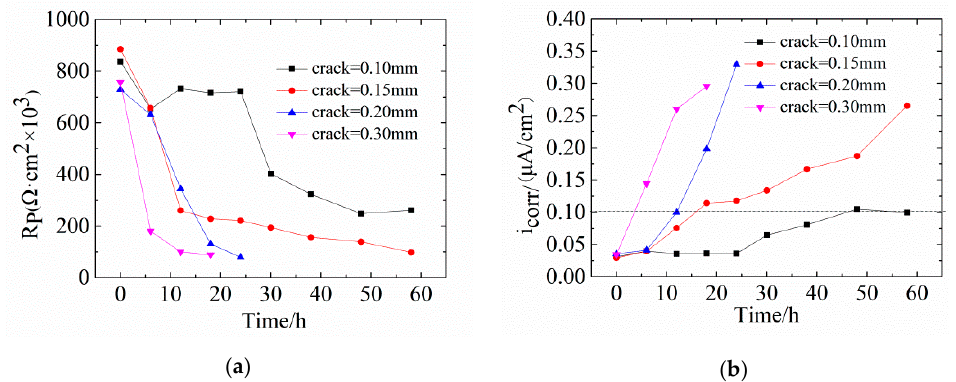
Figure 10. ( a ) Polarization resistance and ( b ) corrosion current density for reinforced corrosion resistant concrete with different transverse crack widths.